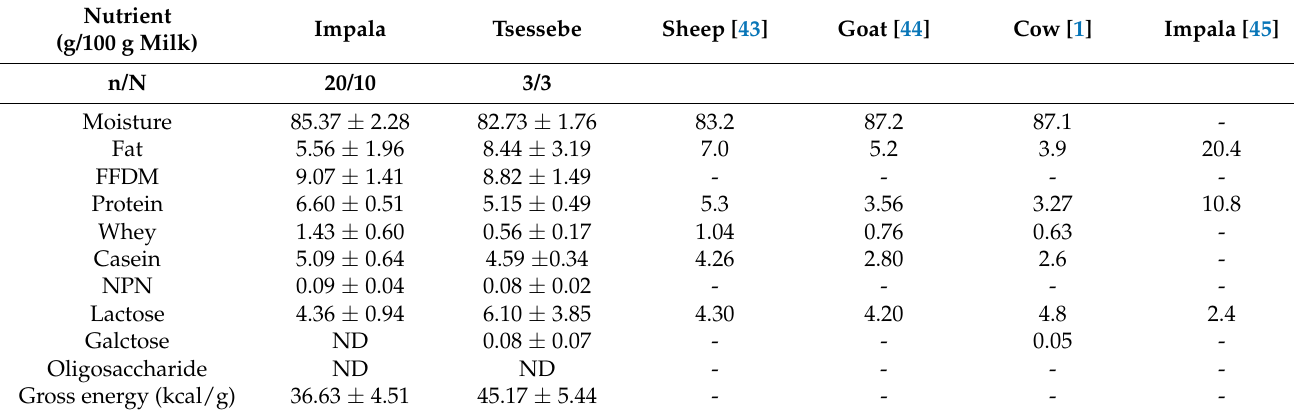
Table 1. Proximate composition of the milk of impala and tsessebe compared to domestic animals.